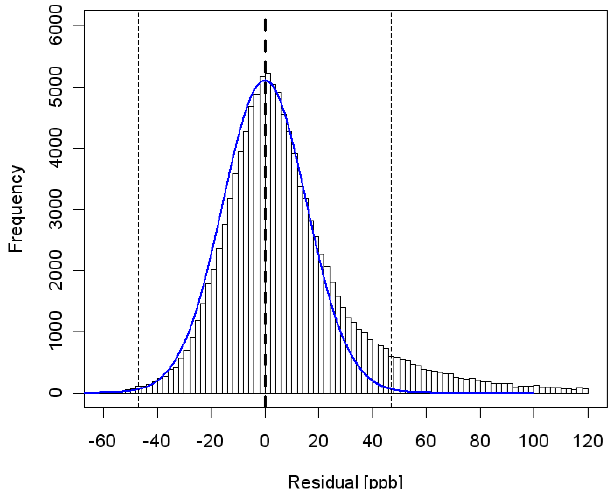
Fig. 1. Histogram of the residuals derived from application of the REBS technique to hourly CO measurements at Jungfraujoch. The estimated scale parameter σ is 15.6ppb. The thick vertical dashed line indicates the estimated mode of the residual distribution; the two thin vertical dashed lines denote the ± 3 σ range. The blue line is a Gaussian distribution fitted to the left side (residuals below the mode) of the residual distribution. The residual distribution can be used for judgement of the applicability of the REBS technique. The REBS should only be applied when the residuals below the mode follow approximately a Gaussian distribution (see Sect.